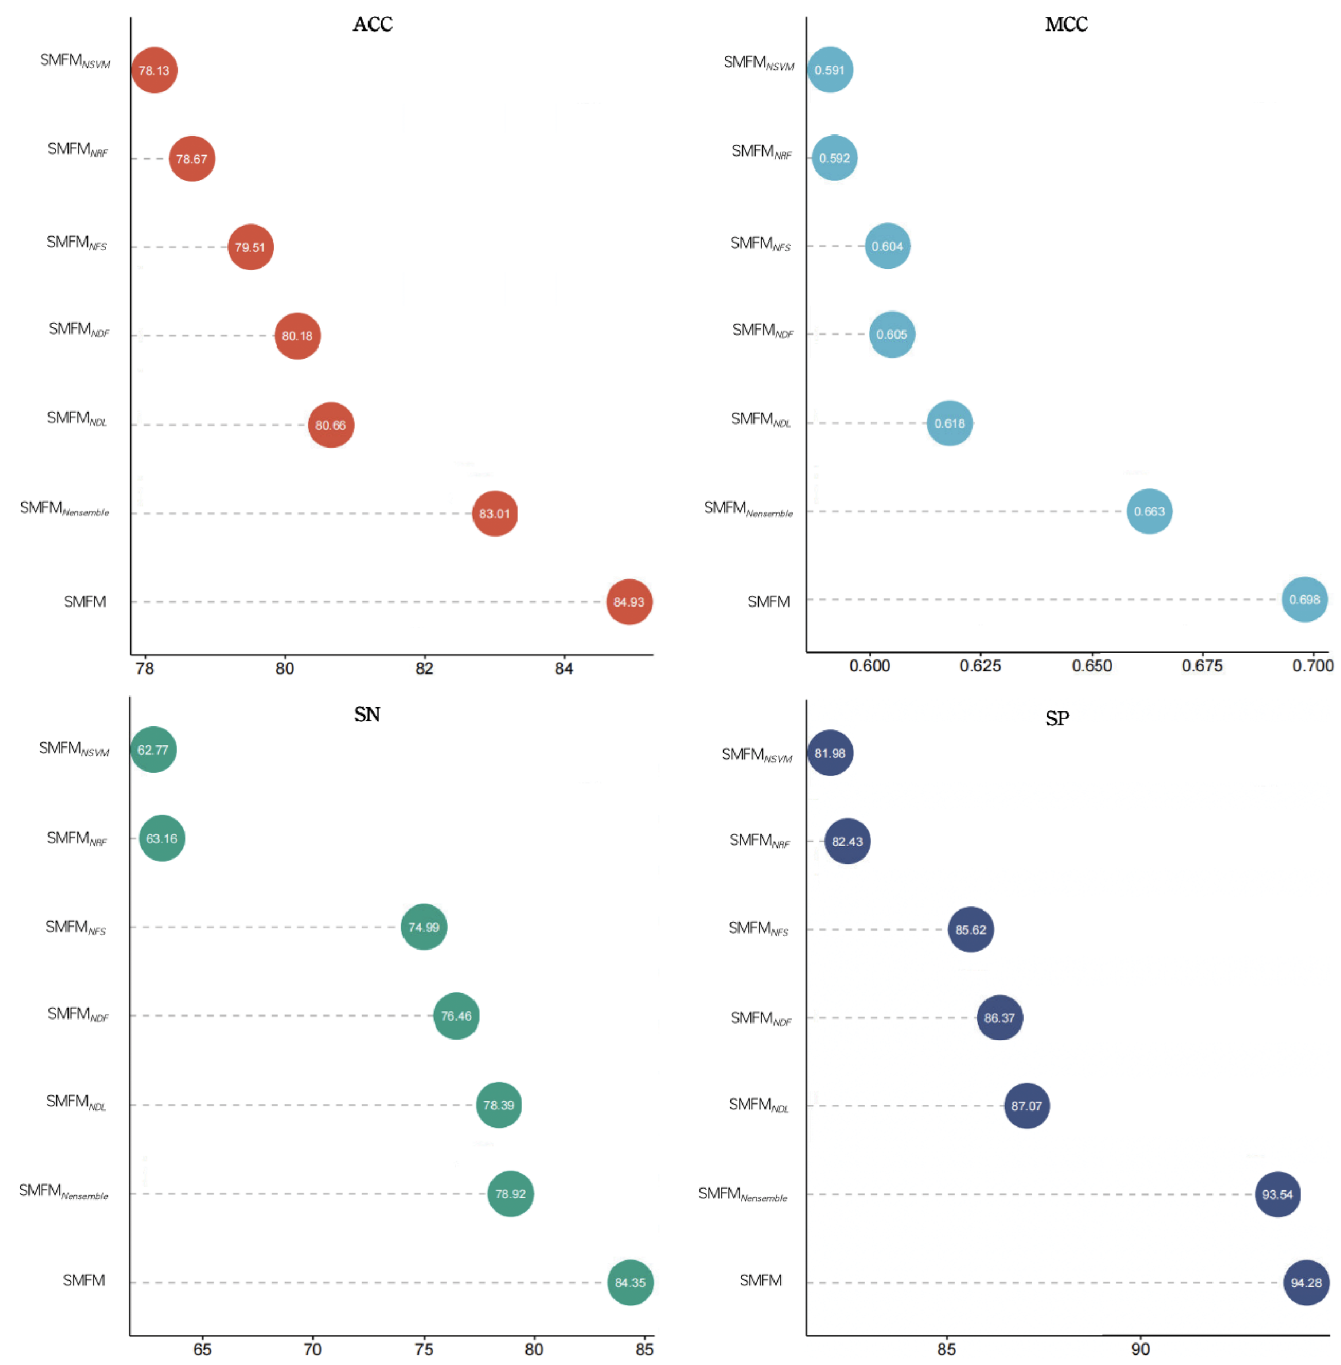
Fig 5. Performance of the different SMFM ablated architectures of SMFM, with ACC, SN and SP values as percent units.